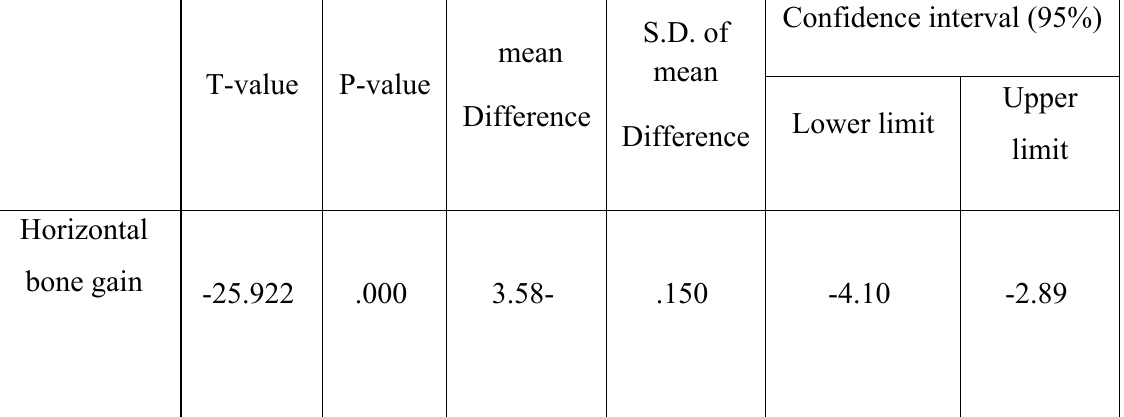
Table 4: Paired T test for samples to study the change in the width of the alveolar bone before and after 3 months of the distraction osteogenesis